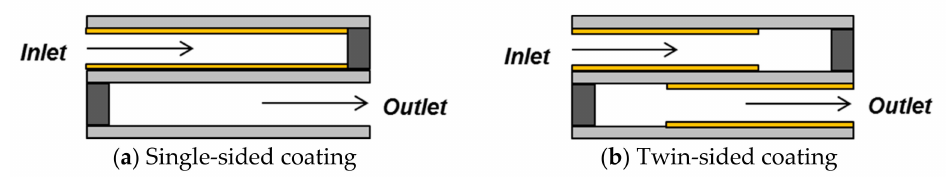
Figure 7. Diagram of two di ff erent catalyst coating of